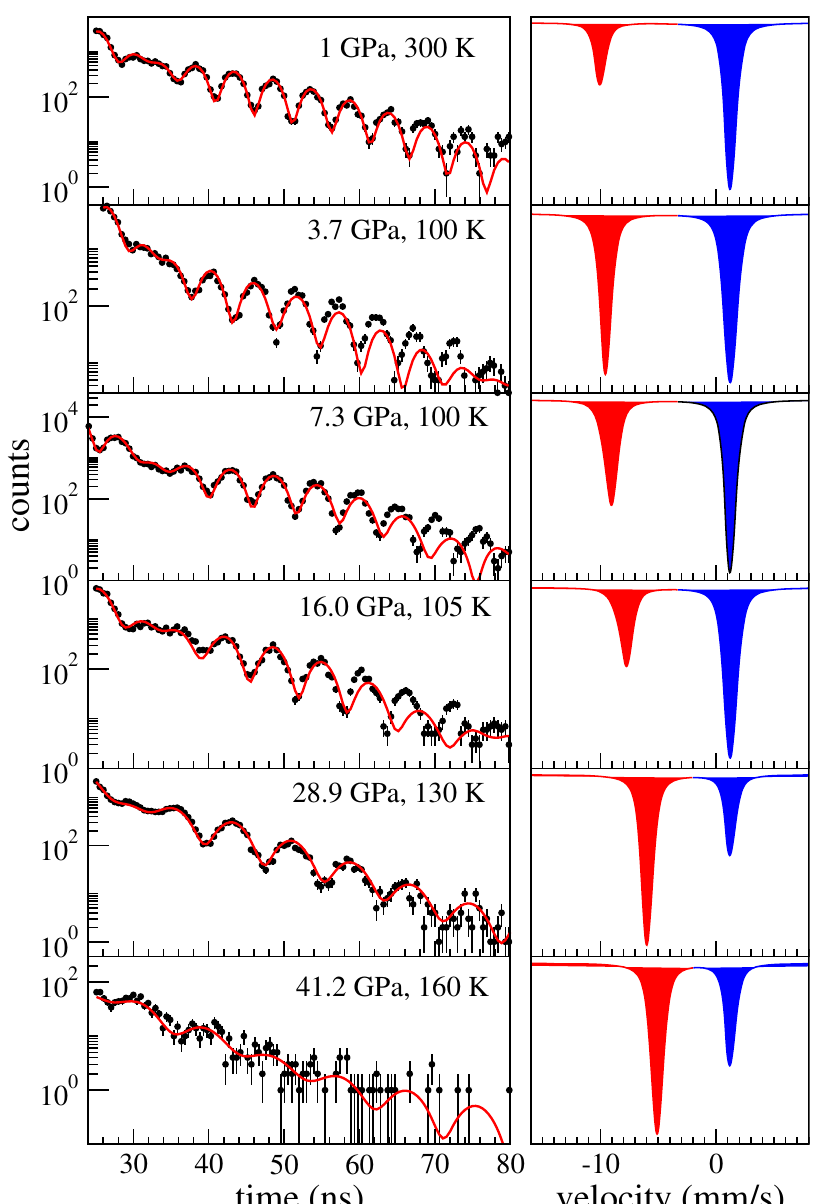
Fig. 5 Isomer shift under pressure. (Left) Representative SMS spectra of 151 Eu from EuSn 2 P 2 in the paramagnetic phase at indicated pressure and temperatures. Eu 2 O 3 is used as reference material to determine the absolute value of the isomer shift and its change with applied pressure. (right) Simulated energy-domain Mössbauer spectra based on the fi tting results from each corresponding SMS spectrum. Red shaded lines indicate the isomer shift from the sample and blue lines show the isomer shift of Eu 2 O 3